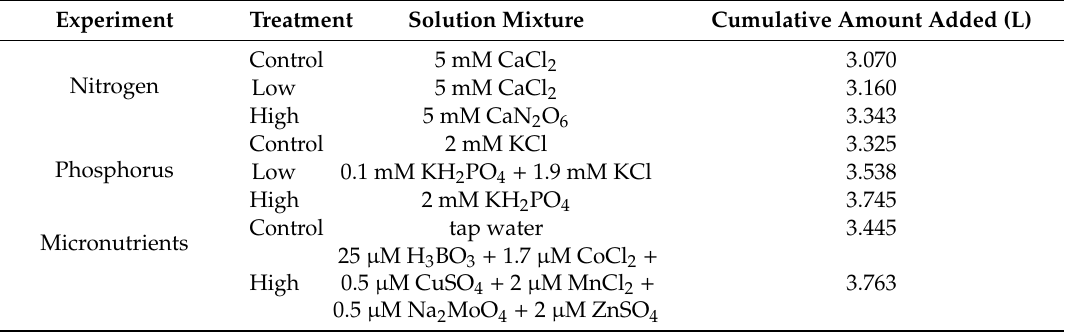
Table 2. Solution mixtures used for each nutrient treatment level in the three nutrient